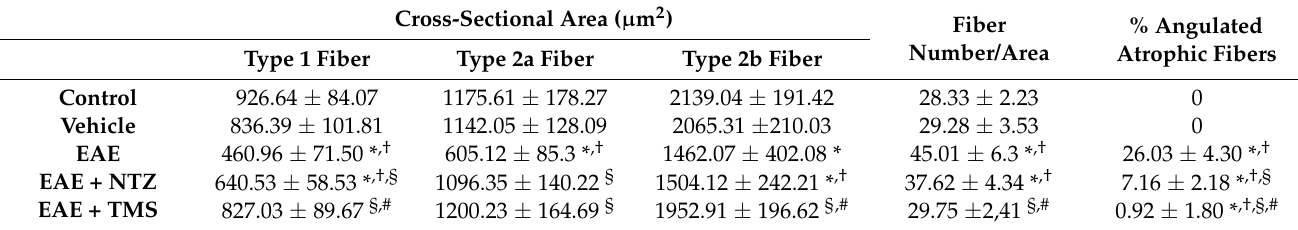
Table 4. Histomorphometric parameters of EDL